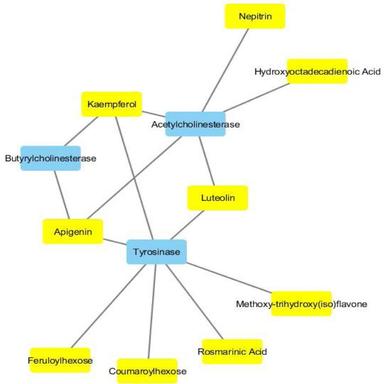
Components-targets analysis highlighting the putative interactions of luteolin, apigenin, feruoylhexose, kaempferol, ccoumaroylhexose, methoxytrihydroxy(iso)flavone, rosmarinic acid, nepitrin and hydroxyoctadecadienoic acid with tyrosinase and cholinesterases.